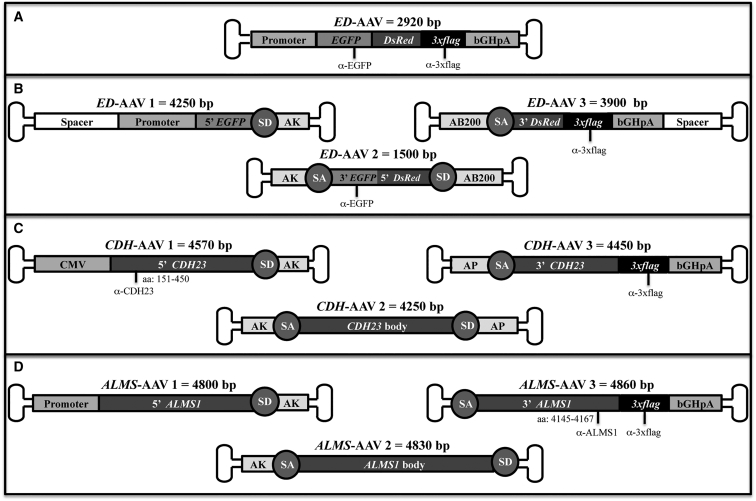
Schematic Representation of Single and Triple AAV VectorsSingle ED-AAV (A); triple ED-AAVs (B); triple CDH-AAVs (C); triple ALMS-AAVs (D). The position of the epitopes recognized by the antibodies used in this study is indicated. The vector genome size is depicted above each vector. bGHpA, bovine growth hormone polyadenylation signal; SD, splicing donor signal; SA, splicing acceptor signal; AP, alkaline phosphatase recombinogenic region; AK, F1 phage recombinogenic region; AB200, ABCA4 recombinogenic region; 3xflag, triple flag tag; CMV, cytomegalovirus; α-EGFP, anti-EGFP antibodies; α-3xflag, anti-3xflag antibodies; α-CDH23, anti-CDH23 antibodies; α-ALMS1, anti-ALMS1 antibodies.